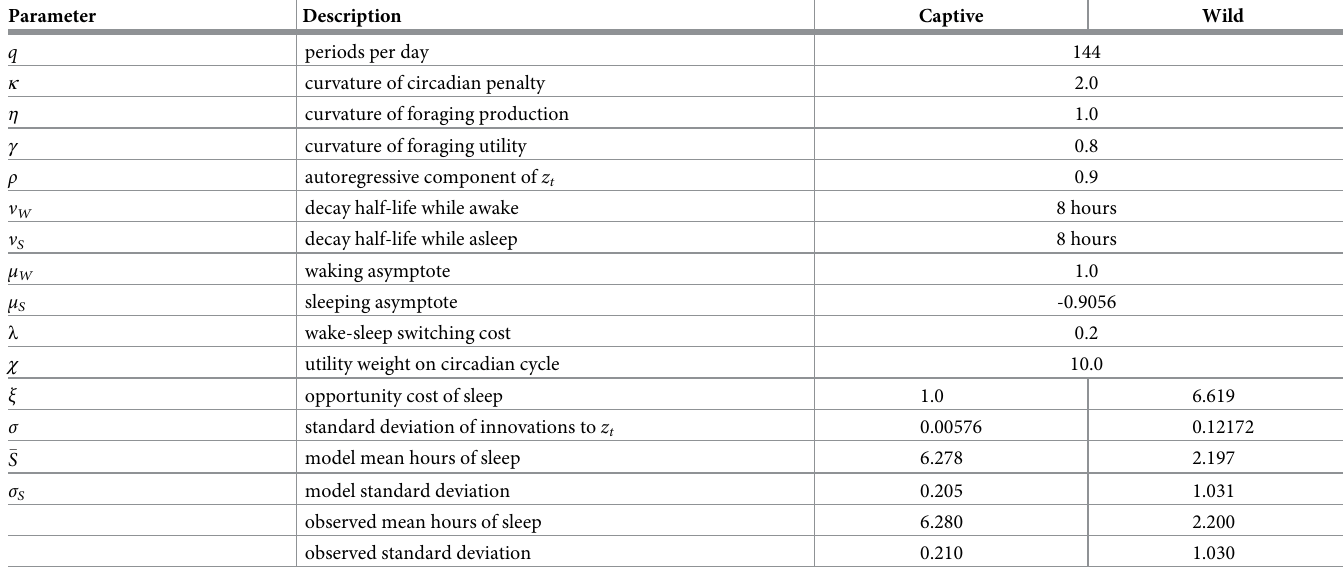
Table 1. Model parameters, predicted and actual sleep for